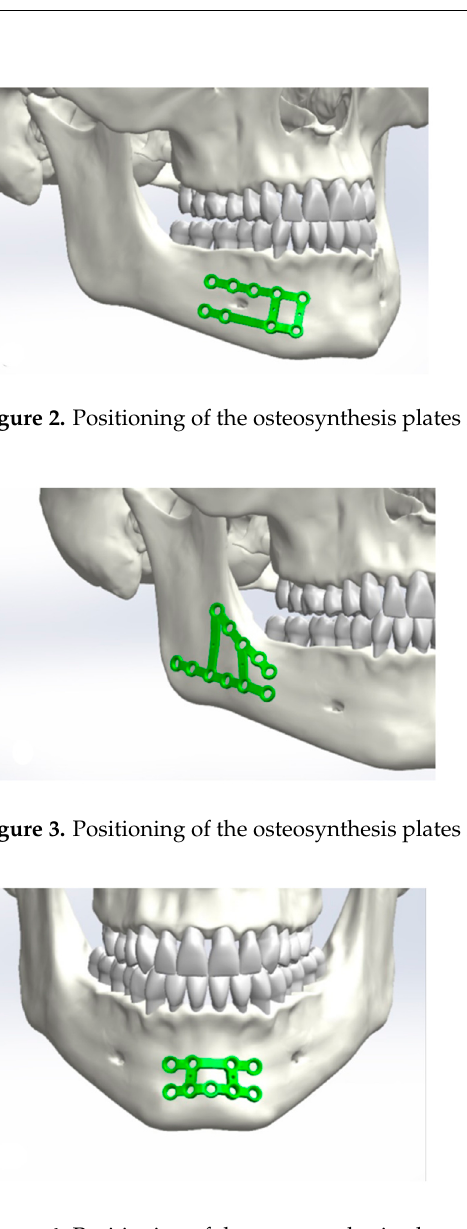
Figure 1. Positioning of the osteosynthesis plates in the area of the condyle.